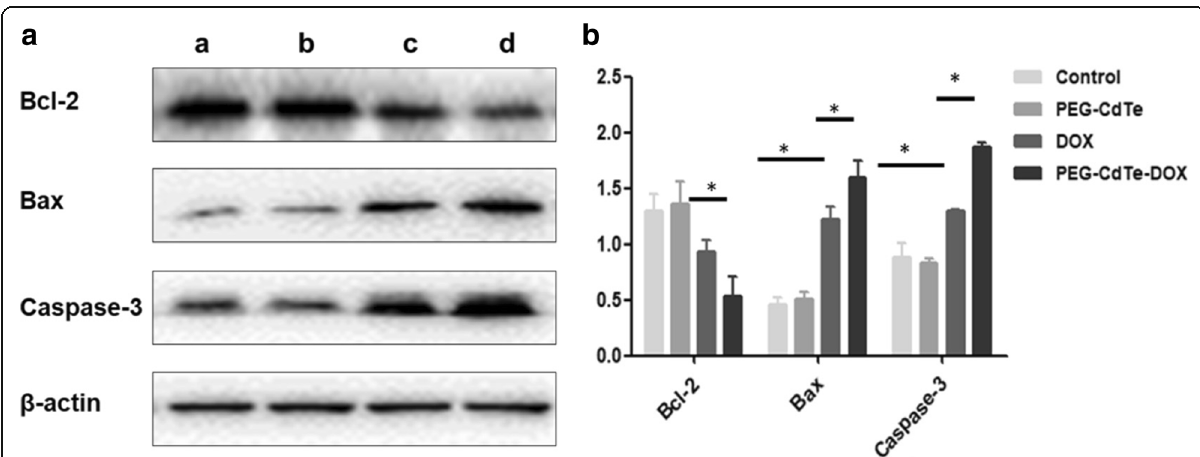
Fig. 6 Protein expression of apoptosis-associated genes of PRMI 8226 cells with different treatments. Notes: a PBS; b PEG-CdTe; c DOX; d PEG-CdTe-DOX (* P <